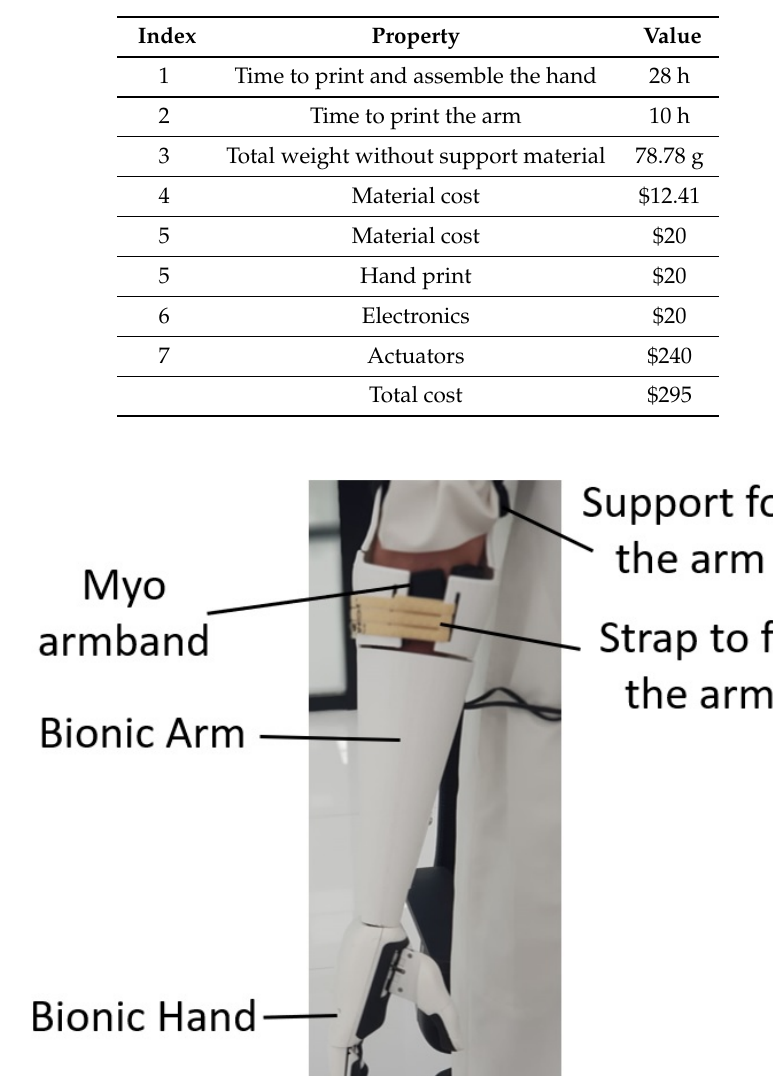
Table 1. Detailed cost analysis of the bionic arm.